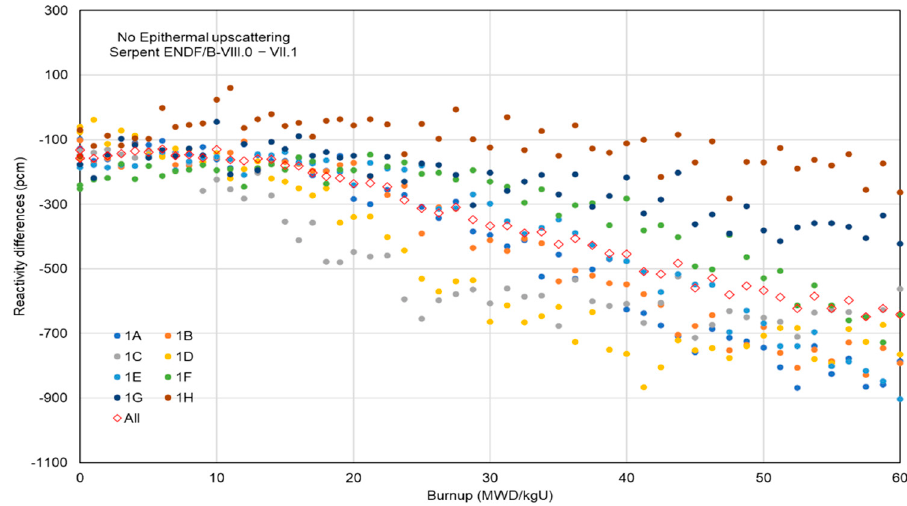
Figure 7. Comparison of the multiplication factors as a function of burnup for the BWR depletion benchmark problems without considering epithermal upscattering.